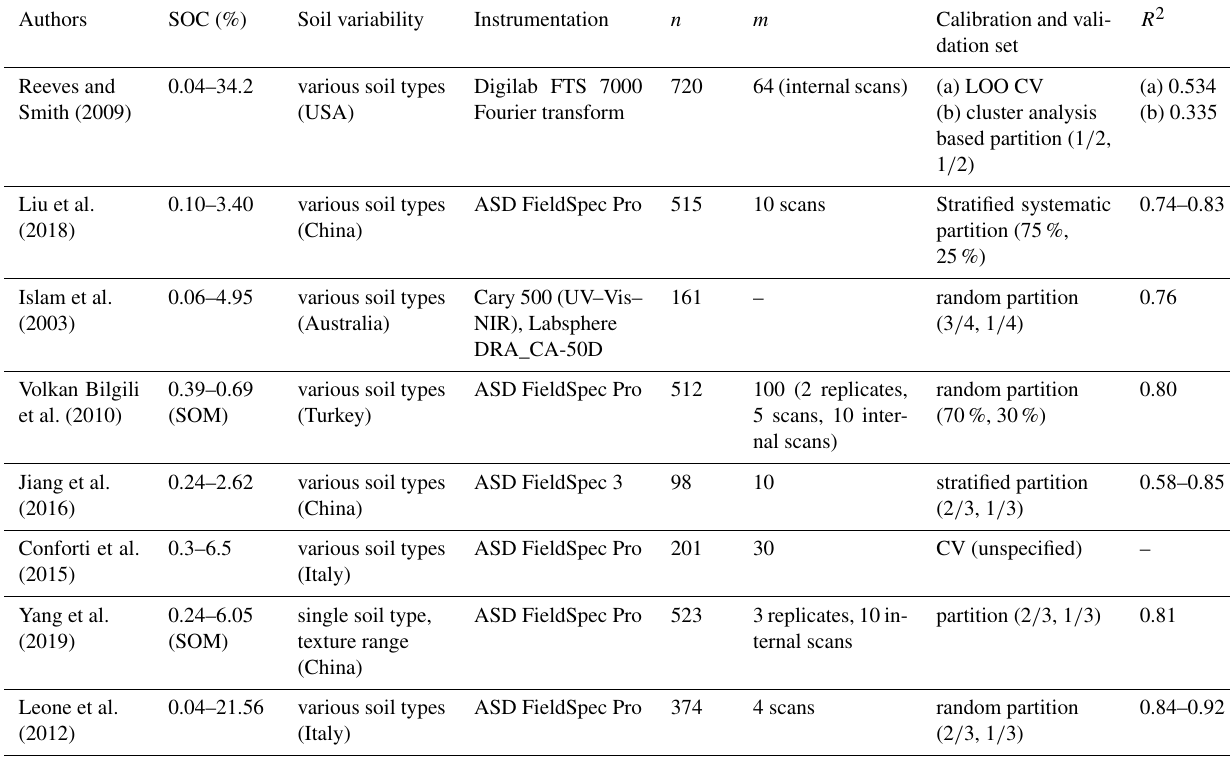
Table 4. R 2 model performance values from Vis–NIR applications to predict